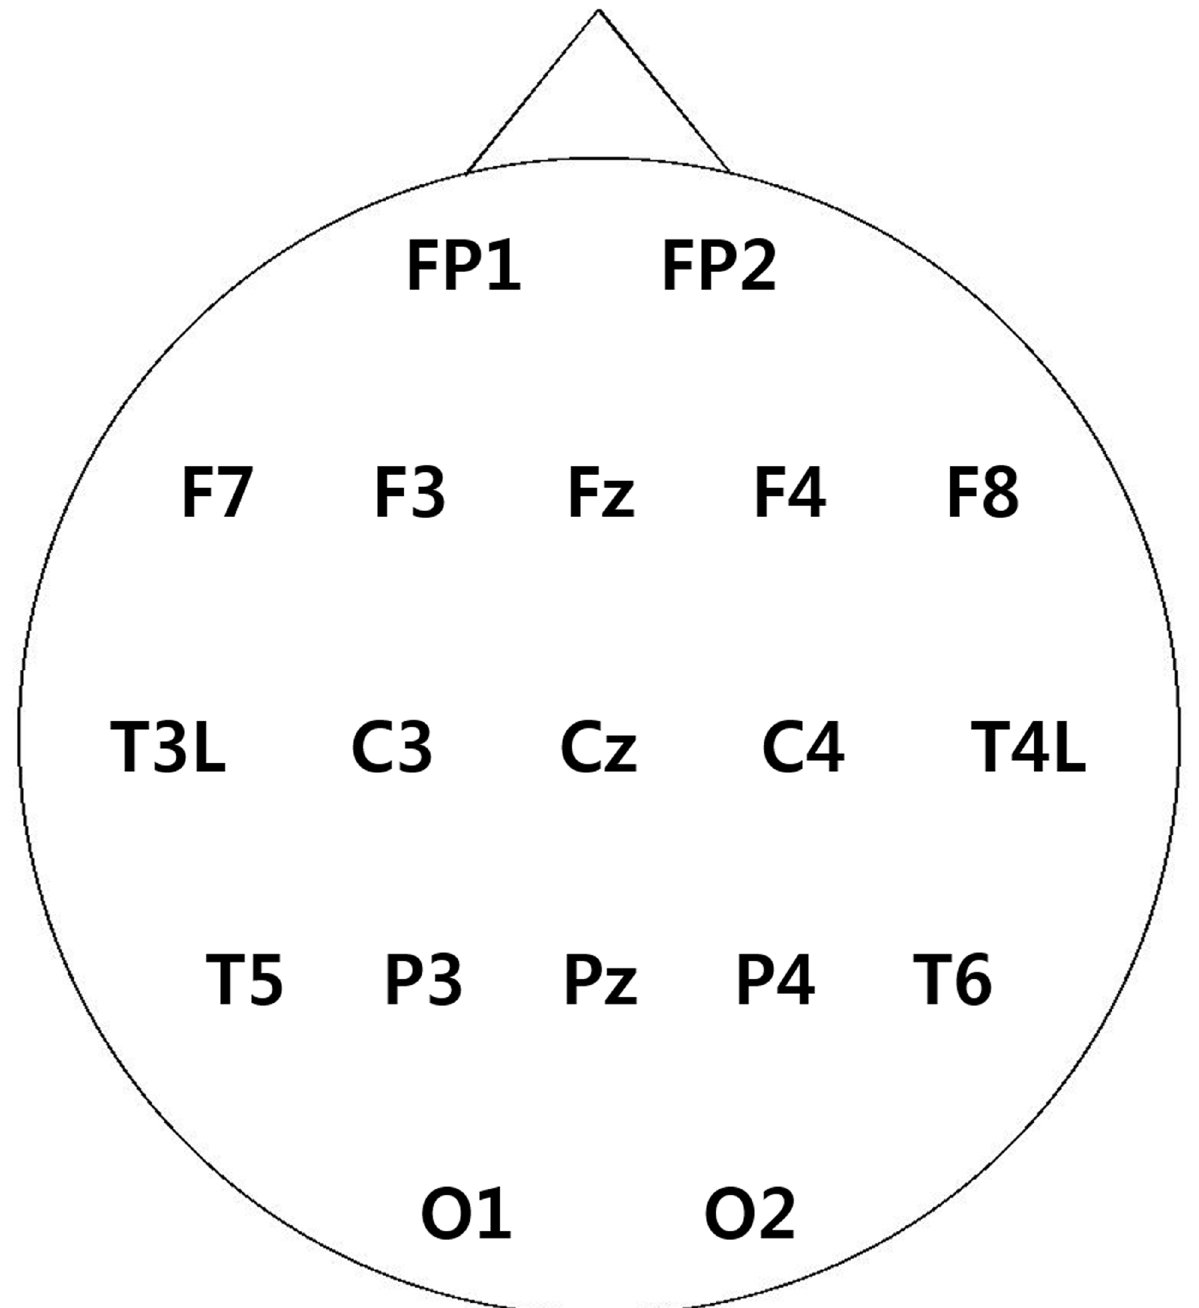
Fig 1. The location of all recording electrodes in the international 10 – 20 EEG